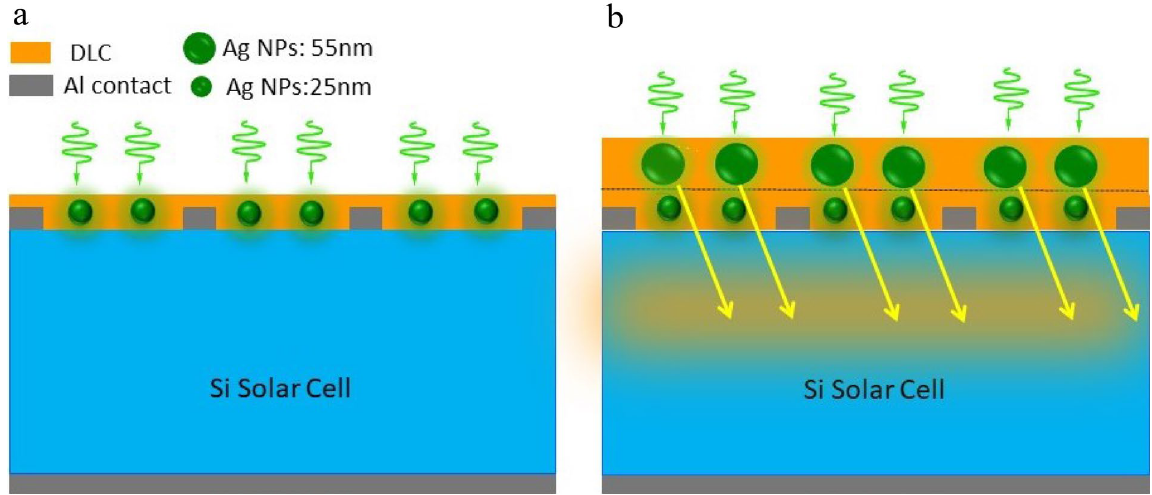
Figure 1. Schematic representation of Ag NPs embedded at DLC: ( a ) monolayer and ( b ) bilayer which create different plasmonic